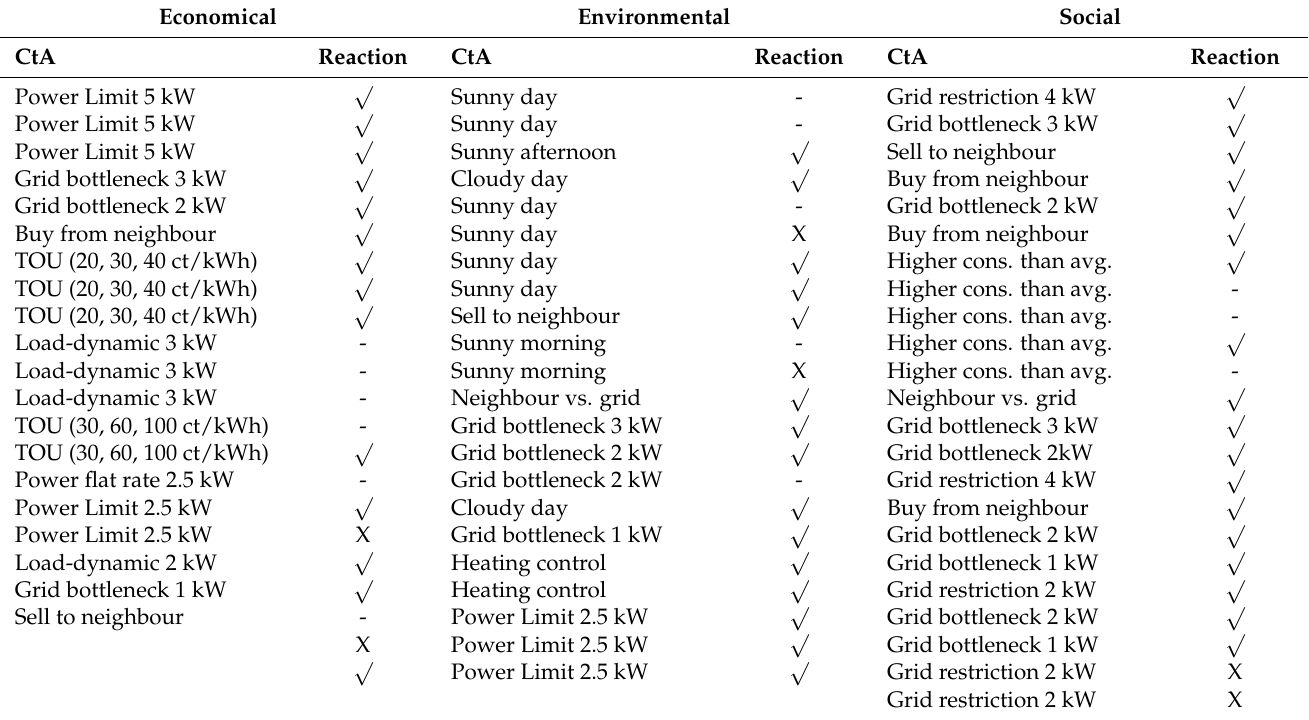
Table 2. Overview of the CtAs and if they were followed by the inhabitants. X: behavior in contrast to the